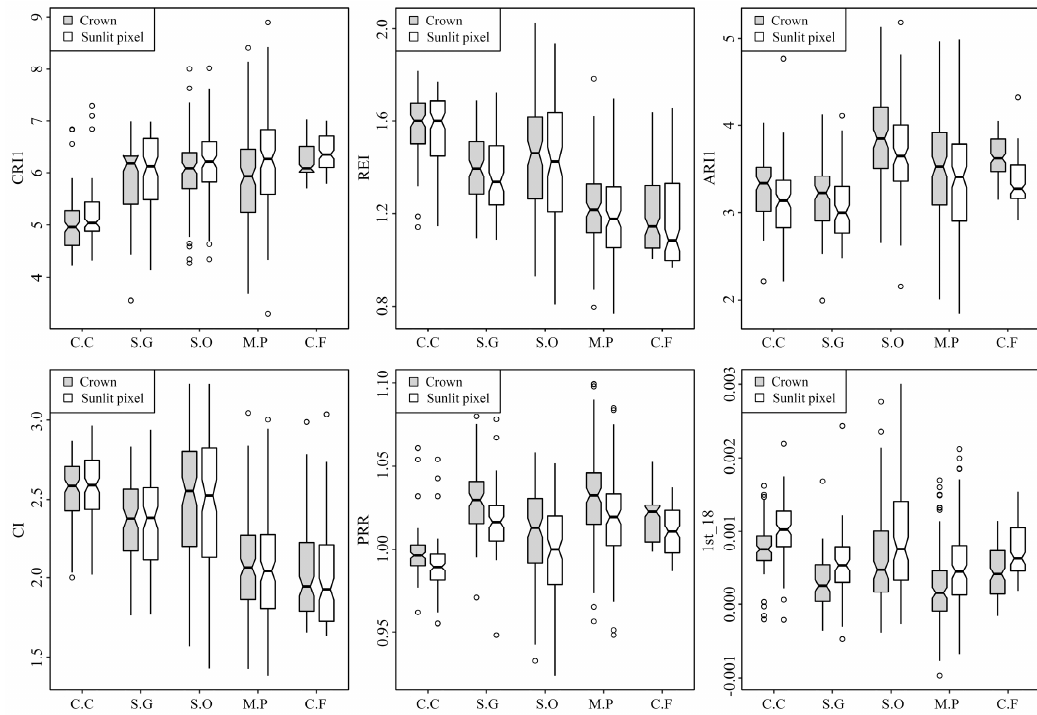
Figure 9. Box plots for selected most important hyperspectral metrics at crown and sunlit crown levels for the five tree-species ( X axis is the five tree-species and Y axis is the most important metrics).